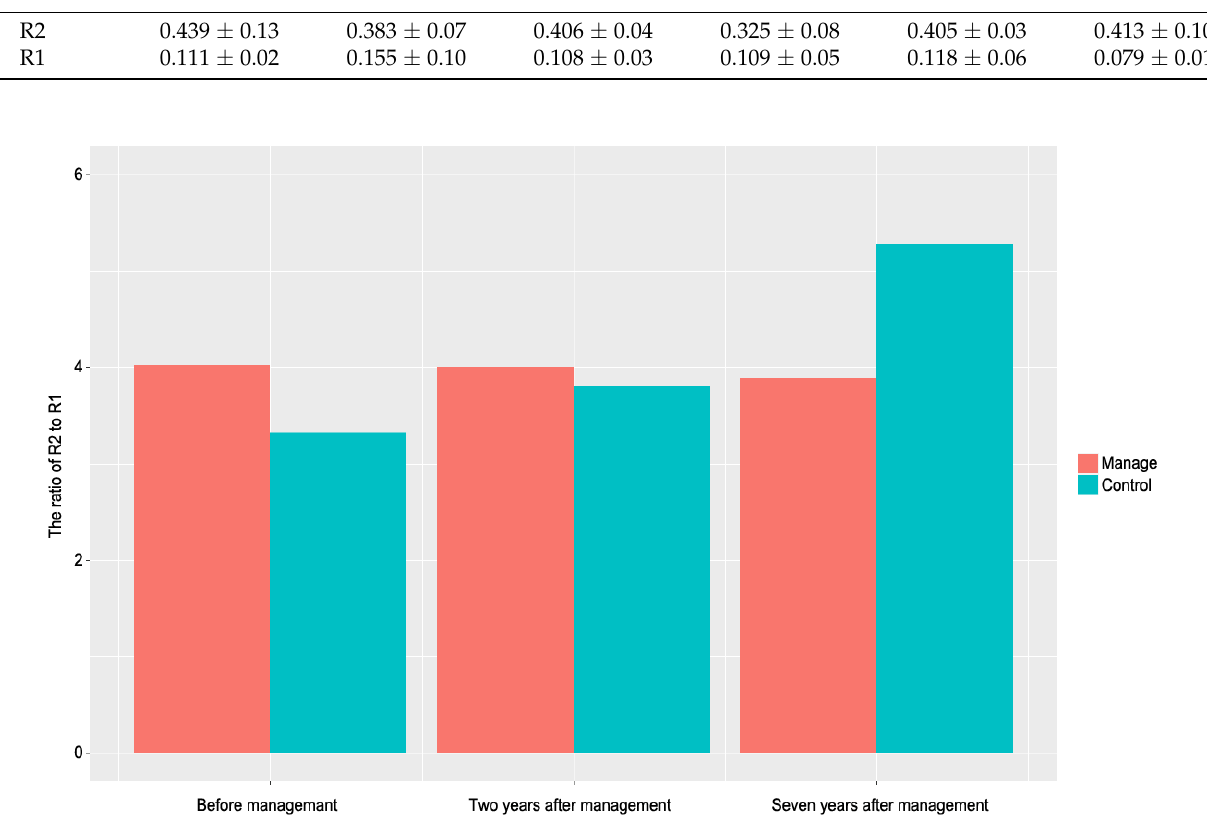
Figure 7. The ratio of R2 to R1 between the SBFM and control